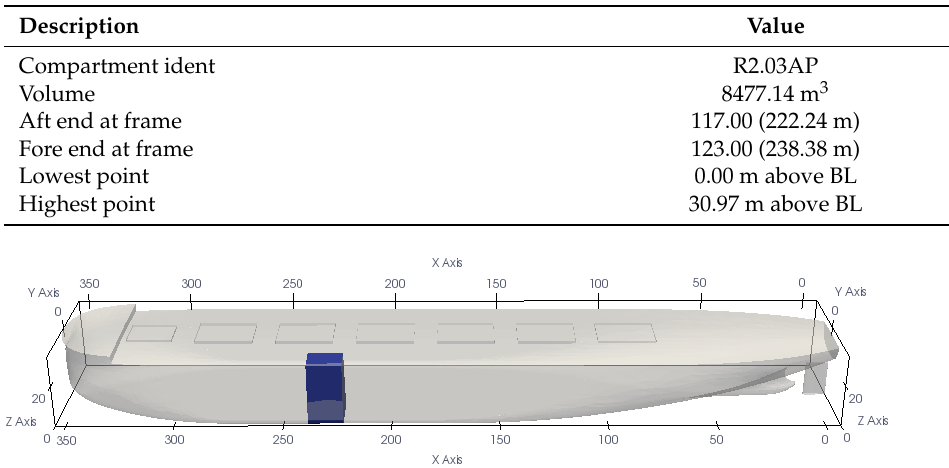
Table 2. Parameters of the water ballast tank “R2.03AP”, from [61].